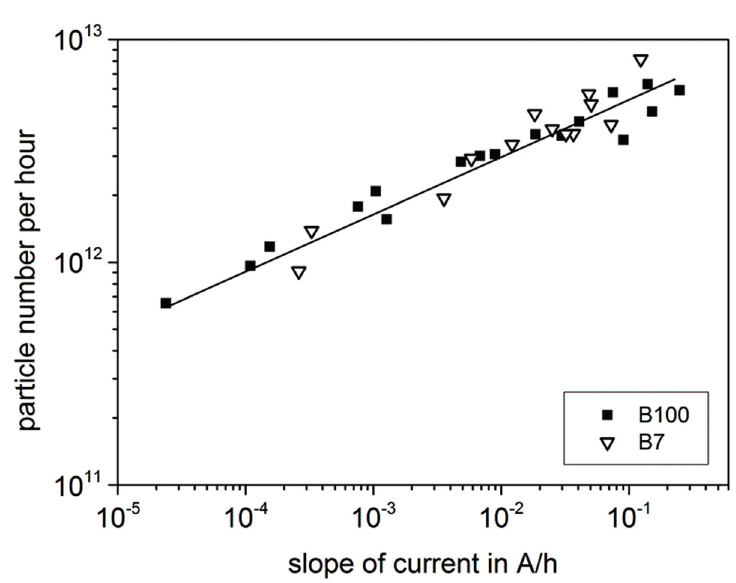
Figure 5. Correlation between evaluated sensor data and achieved particle number per hour. Similar results are achieved for the evaluation with respect to the particle mass (Figure 6). Here, the double-logarithmic representation reveals an impressing linear dependency, independent on the used fuel.